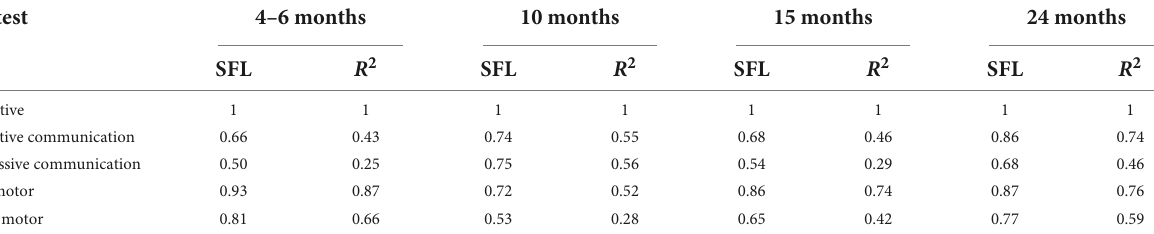
TABLE 6 Standardized factor loadings for a three-factor model.